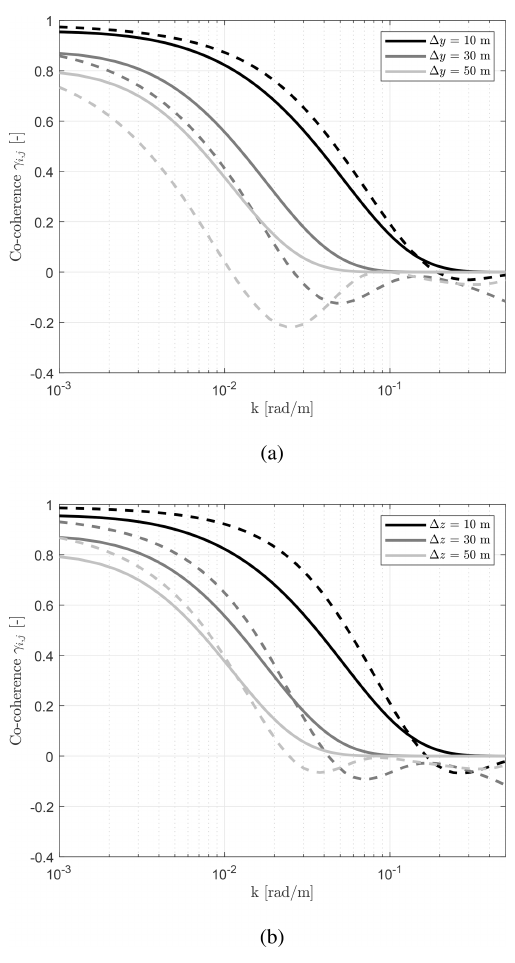
Figure 2. Co-coherence at different separation distances. (cid:49) y and (cid:49) z represent the lateral and vertical separation distances, re- spectively. (a) Lateral co-coherence: (cid:49) z = 0m. (b) Vertical co- coherence: (cid:49) y = 0m. Dashed lines denote the Mann model, and solid lines denote the Kaimal